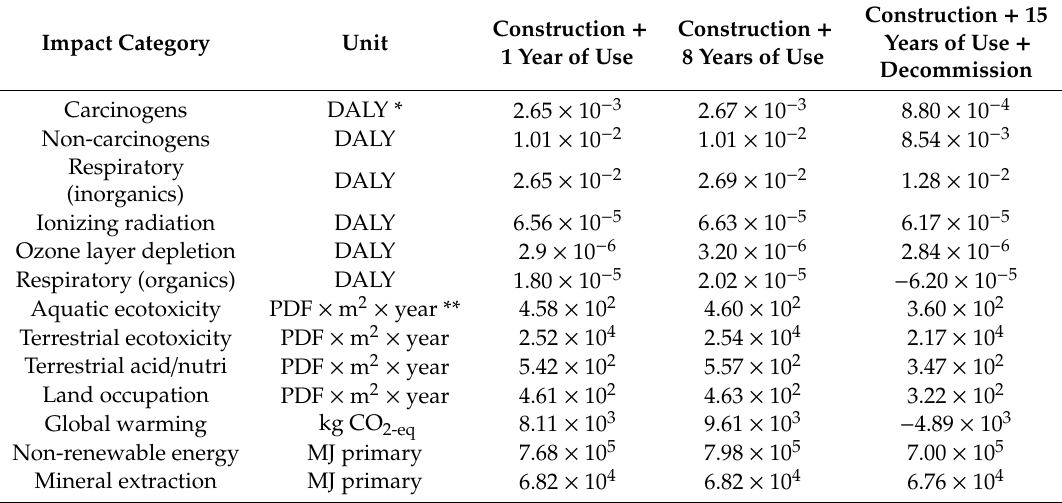
Table 2. Impact assessment and characterization per impact category for a 500-kW heat output Stirling cycle HP.